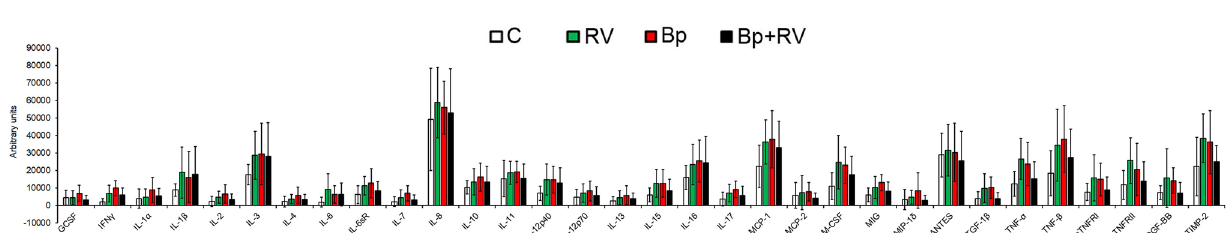
Figure 3. Pattern of undifferentiated inflammatory proteins in the screening cohort. The histogram reported the mean ± SD of semi-quantitative expression in controls (C), RV patients, Bp patients, and Bp + RV patients of undifferentiated inflammatory molecules screened by